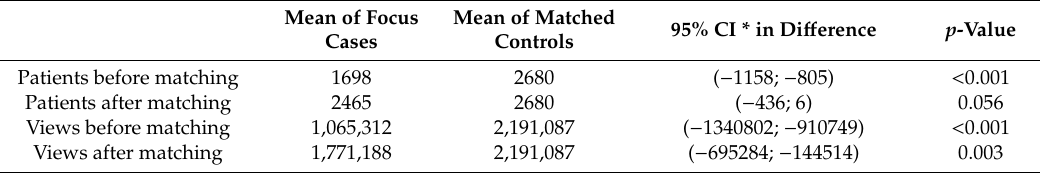
Table 3. Statistics of the Empirical Experimental Data ( n = 2603).